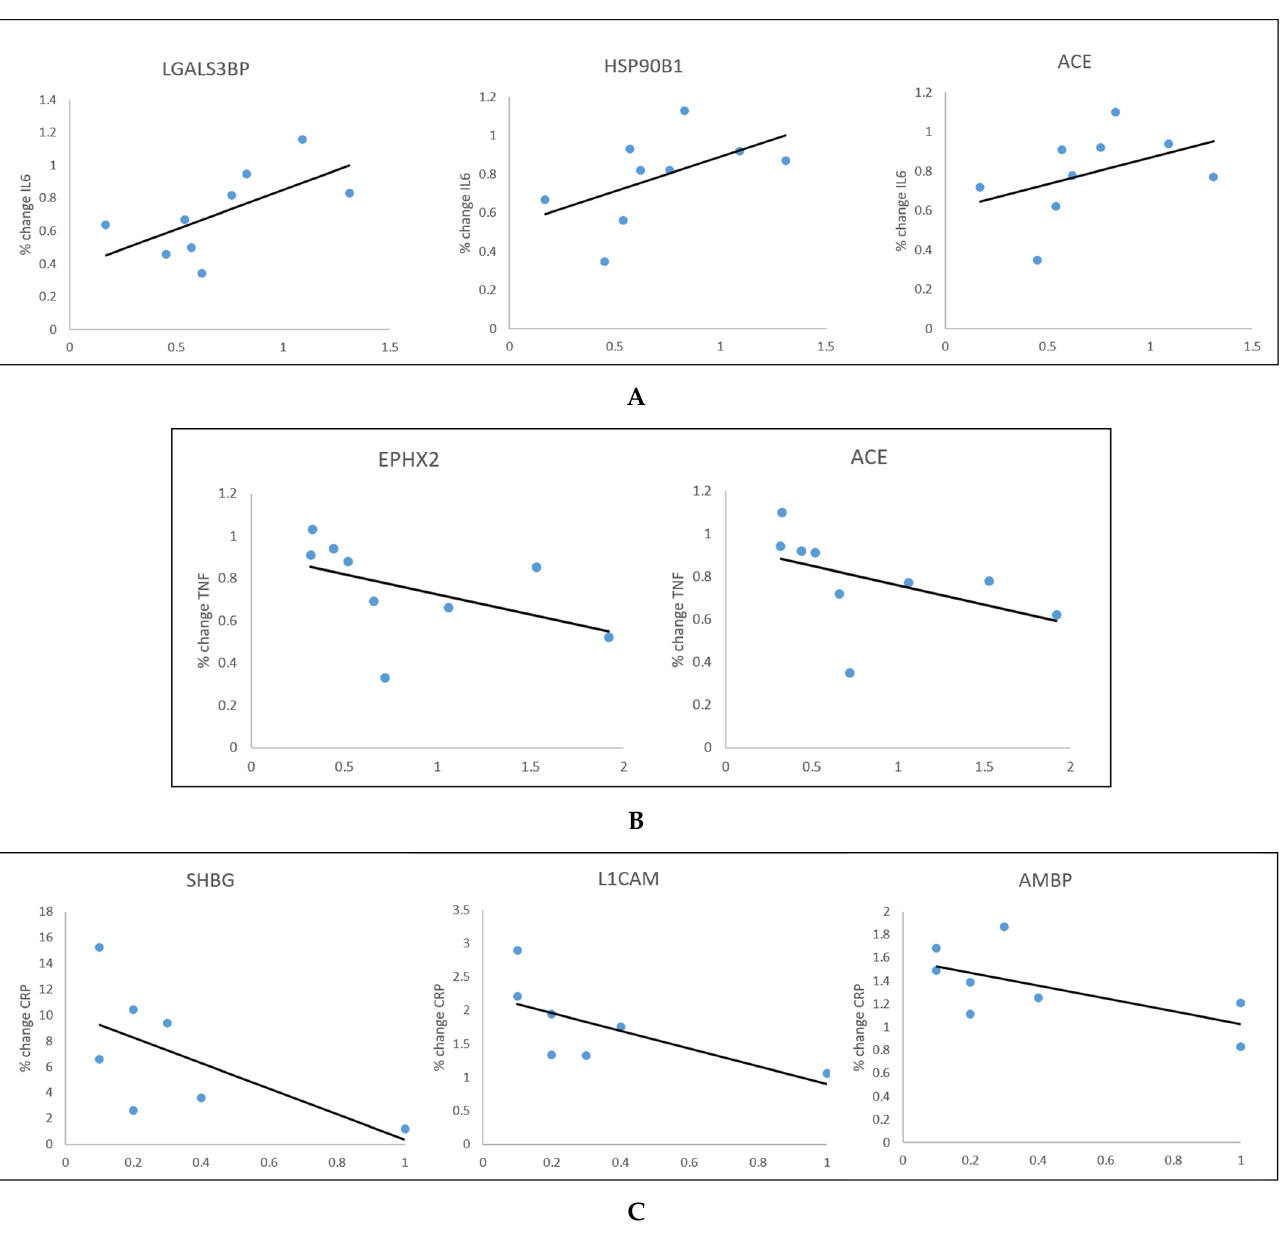
Figure 2. Spearman’s correlations between IL6 ( A ), TNF α ( B ) and CRP ( C ) and plasma proteins at 12 months post-bariatric surgery.